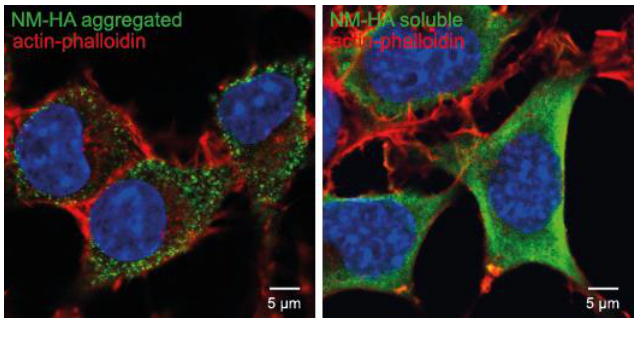
Figure 4. Propagation of cytosolic prions derived from the S. cerevisiae Sup35 prion domain NM. N2a cells ectopically express the HA-tagged prion domain NM of Sup35, which is the most well characterized yeast prion. The left image shows aggregated NM-HA (green) after induction with recombinant NM fibrils, the right image shows the soluble NM-HA (green). NM was stained with anti-HA antibody. F-Actin was stained with fluorescently conjugated phalloidin (red). Nuclei were stained with Hoechst (blue). Scale bar: 5